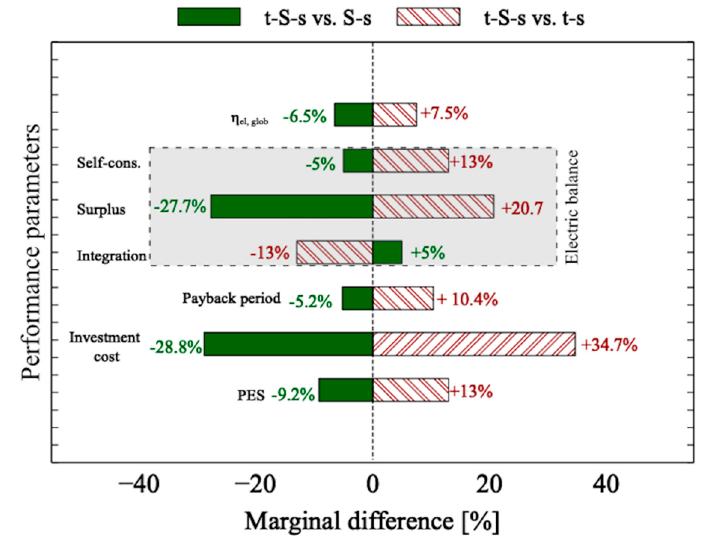
Figure 13. Marginal differences in performance of the t-S-s optimized configuration with respect to the bi-variable optimizations.